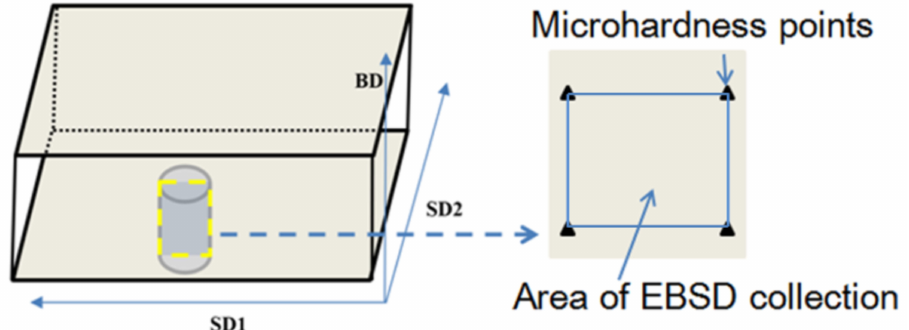
Figure 2. Schematic diagram of insitu region interception and